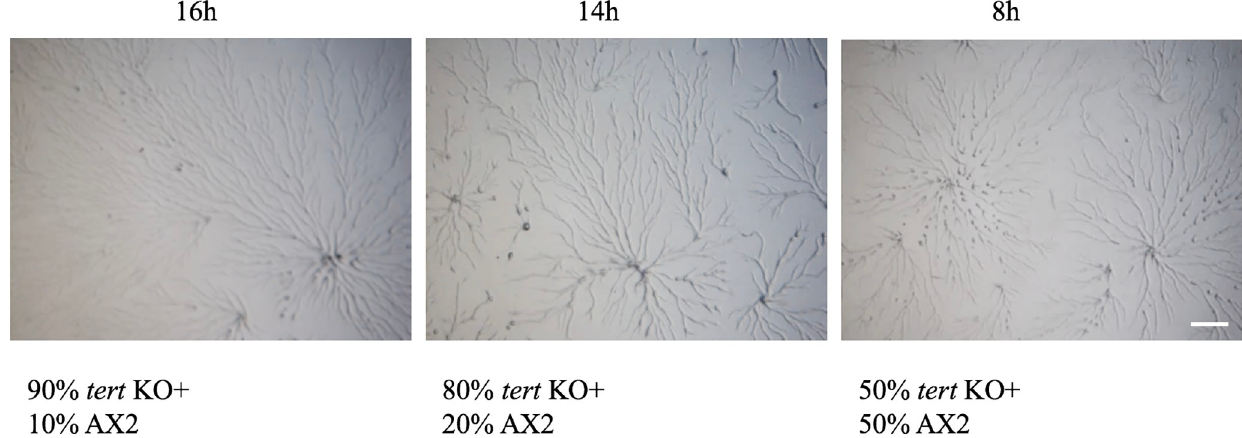
Fig 15. Rescue of delay by added wild-type cells. Wild-type AX2 and tert KO were reconstituted at 1:9, 2:8 and 1:1 ratio and developed on KK 2 agar. Developmental delay of tert KO was rescued by AX2 at 1:1 ratio. Scale bar: 0.5 mm; (n = 3).